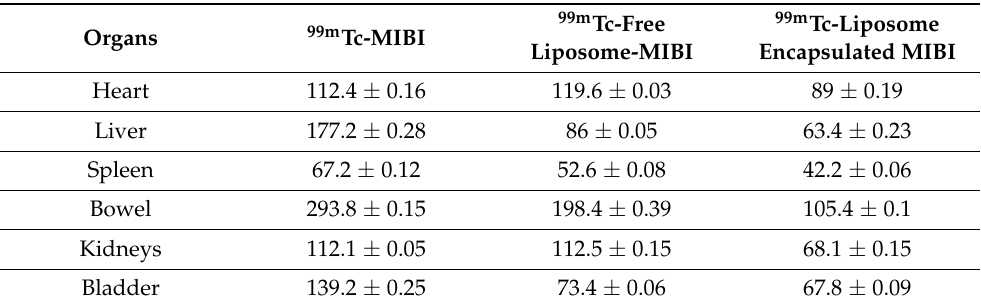
Table 3. Biodistribution of 99m Tc-MIBI compared to 99m Tc-liposomal agents in different organs 24 h post injection.